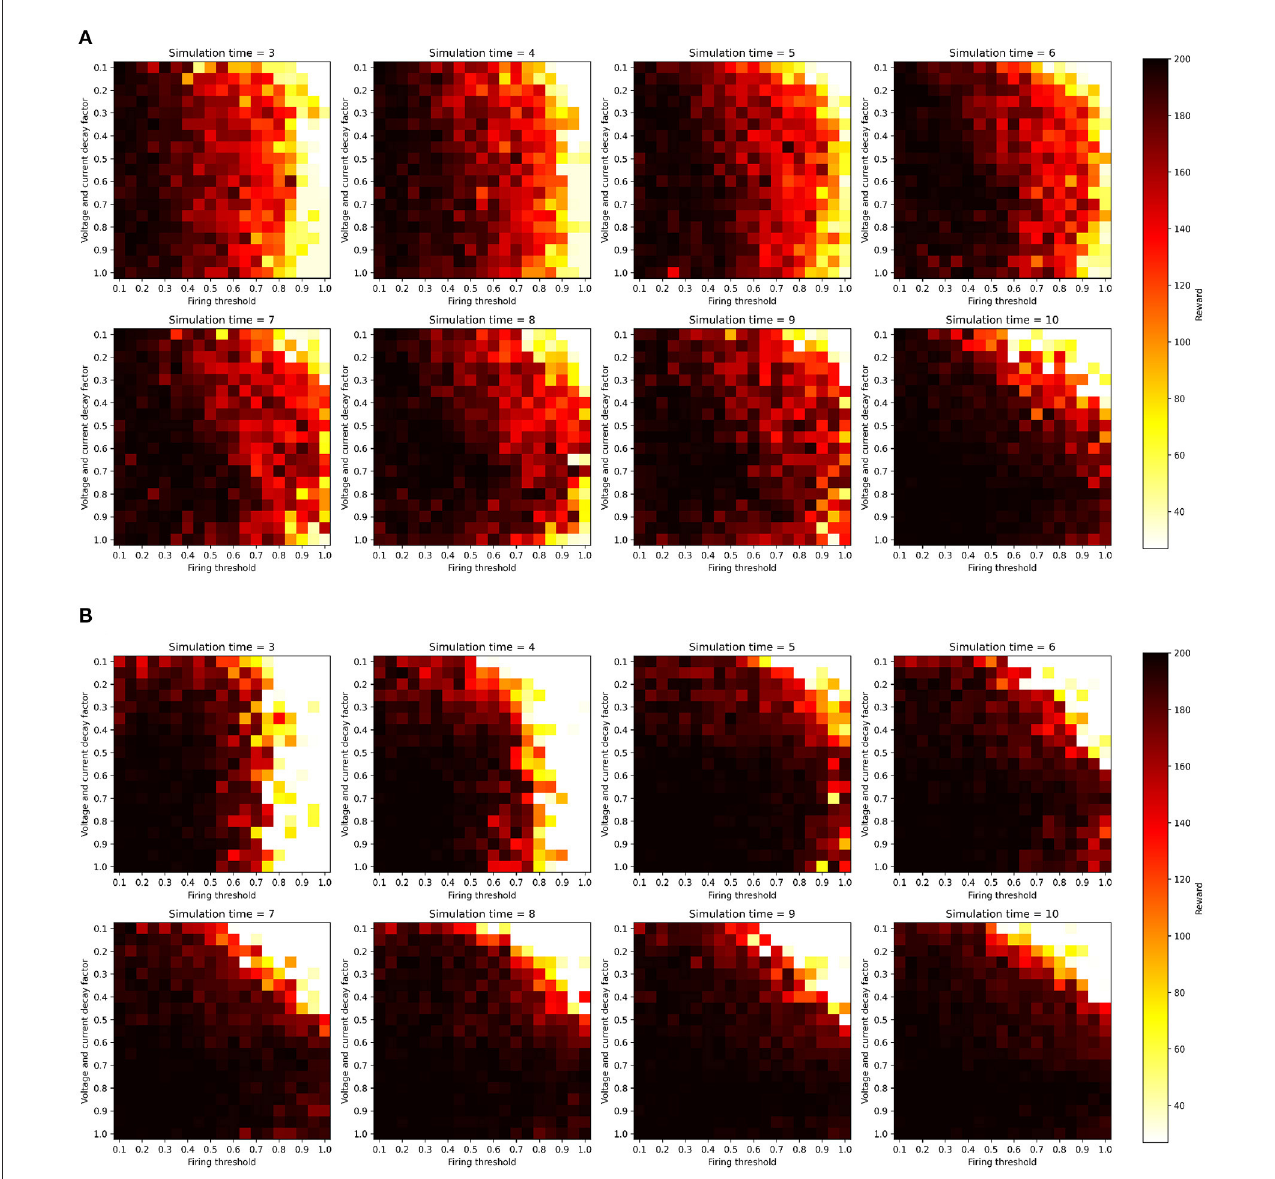
FIGURE3 SNN hyperparameter search results over firing threshold and decay factor combinations for multiple simulation times, measured on the CartPole-v0 problem when trained with the DQN algorithm. All parameter combinations were used to train SNNs for 1,000 episodes, and the z-axis shows the maximum reward achieved during training. All experiments were conducted with the same random seeds controlling network weight initialization and environment’s initial configuration. (A) One-neuron encoding. (B) Two-neuron